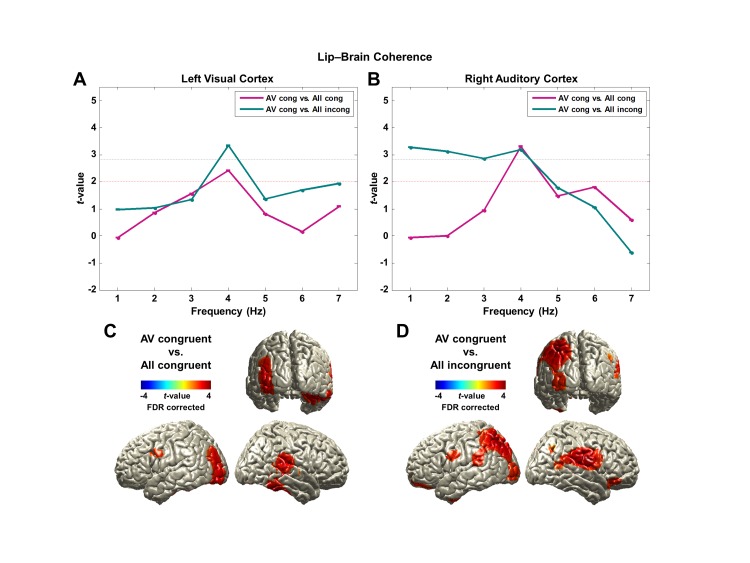
Lip-brain coherence.(A, B) Modulation of lip entrainment by attention and congruence in ROIs.Contrasting AV congruent with All congruent for the effect of attention and with All incongruent for the effect of congruence are shown in left visual (superior/middle/inferior occipital gyri) and right auditory (Heschl’s gyrus) areas defined by AAL ROI maps (paired t-test, df: 43, red dashed line: p<0.05, gray dashed line: p<0.05, corrected) at each frequency from 1 to 7 Hz. The strongest difference was observed at 4 Hz for both contrasts in both areas.(C, D) Spatial distribution of lip entrainment modulation by attention and congruence at 4 Hz (p<0.05, FDR corrected). Significant effects are observed in left visual areas, right superior and middle temporal gyri including Heschl’s gyrus, posterior superior temporal sulcus (pSTS), left precentral gyrus and right inferior frontal gyrus (IFG; BA 44/6).